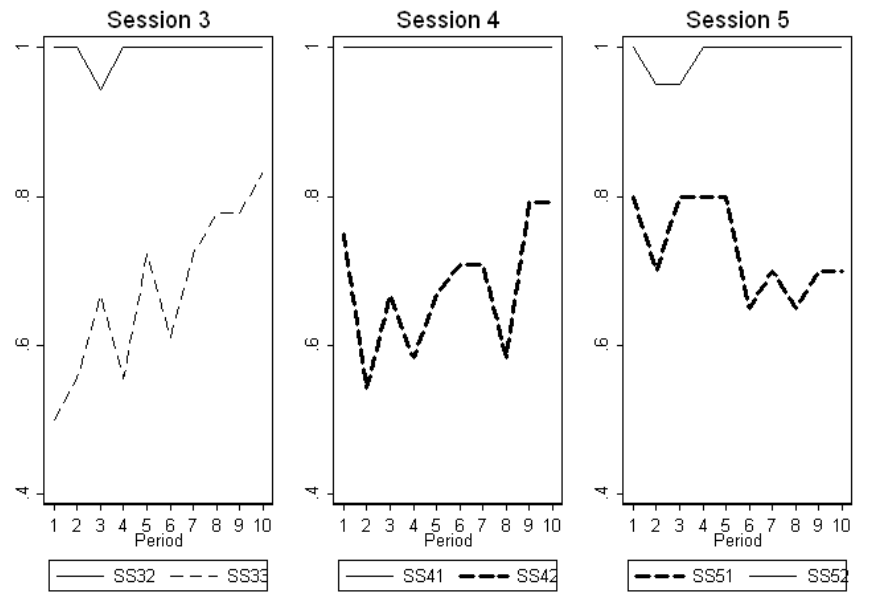
Figure 4. By period fraction of subjects communicating. Solid lines show c = 0, thick dashed lines c = 3 and thin dashed lines c =